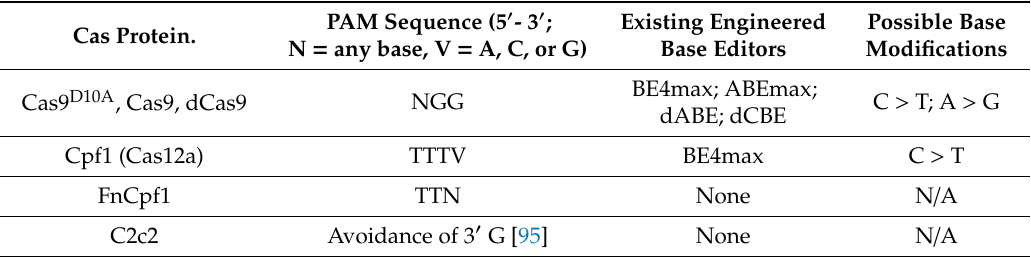
Table 1. Existing and proposed base editors with various protospacer adjacent motif (PAM) sequences and possible base